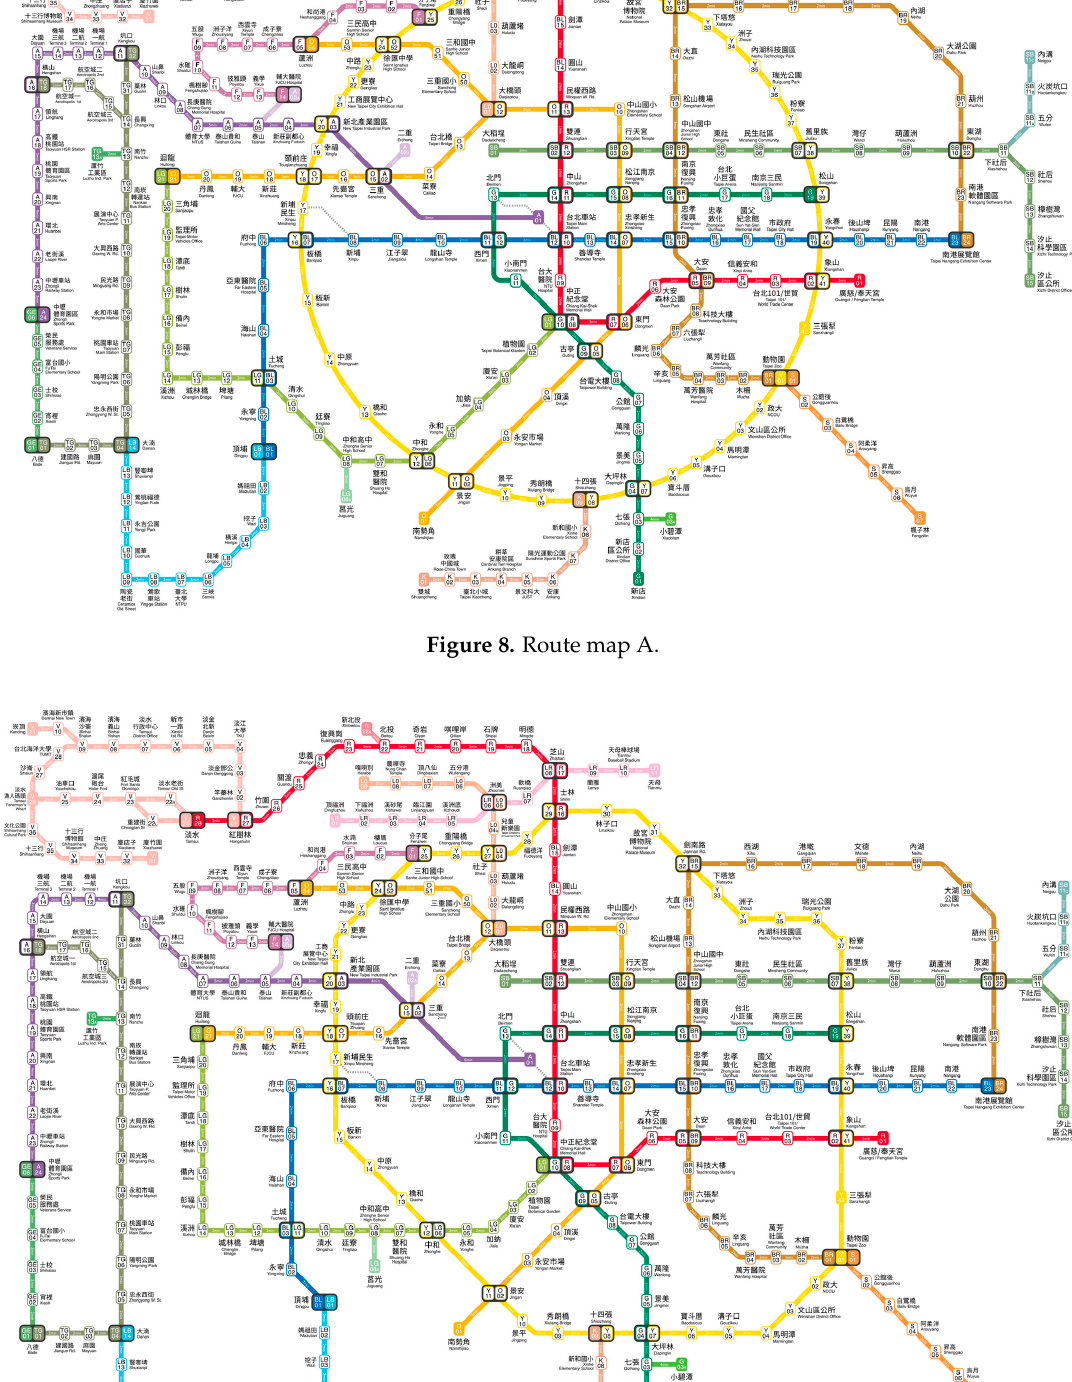
Figure 9. Route map B.